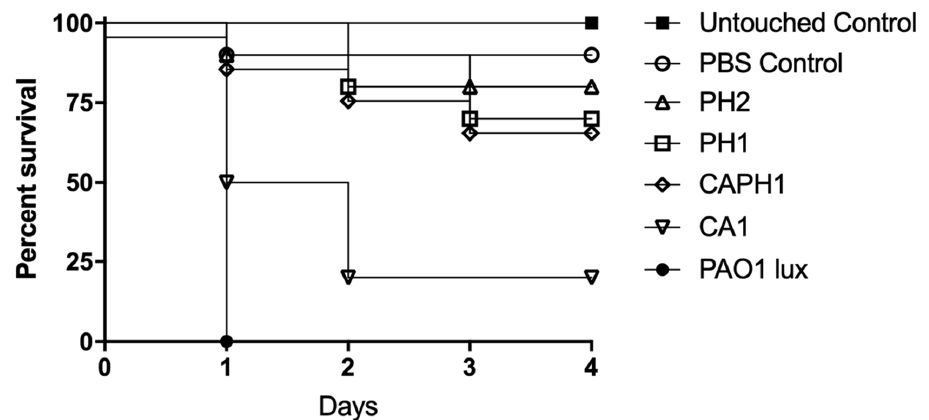
Figure 5. Kaplan–Meier survival curve for Galleria wax worms inoculated with PAO1:: lux mutants recovered from mouse dorsal wounds post-treatment. Original PAO1:: lux was used as a positive control, and an untouched group and PBS in- jected group served as negative controls. PH1 and PH2 were isolates obtained from mice in the phage-only treatment group. CA1 was collected from the CAZ-only treatment group, and CAPH1 was obtained from the combination treatment group. PH2, PH1, and CAPH1 showed a significant increase in survival compared to the PAO1:: lux ( p < 0.0001). Note: the survival curves for PH1 and CAPH1 were identical; thus, the survival curve for CAPH1 was moved below PH1 so that the symbols for each curve are discernible on the graph.